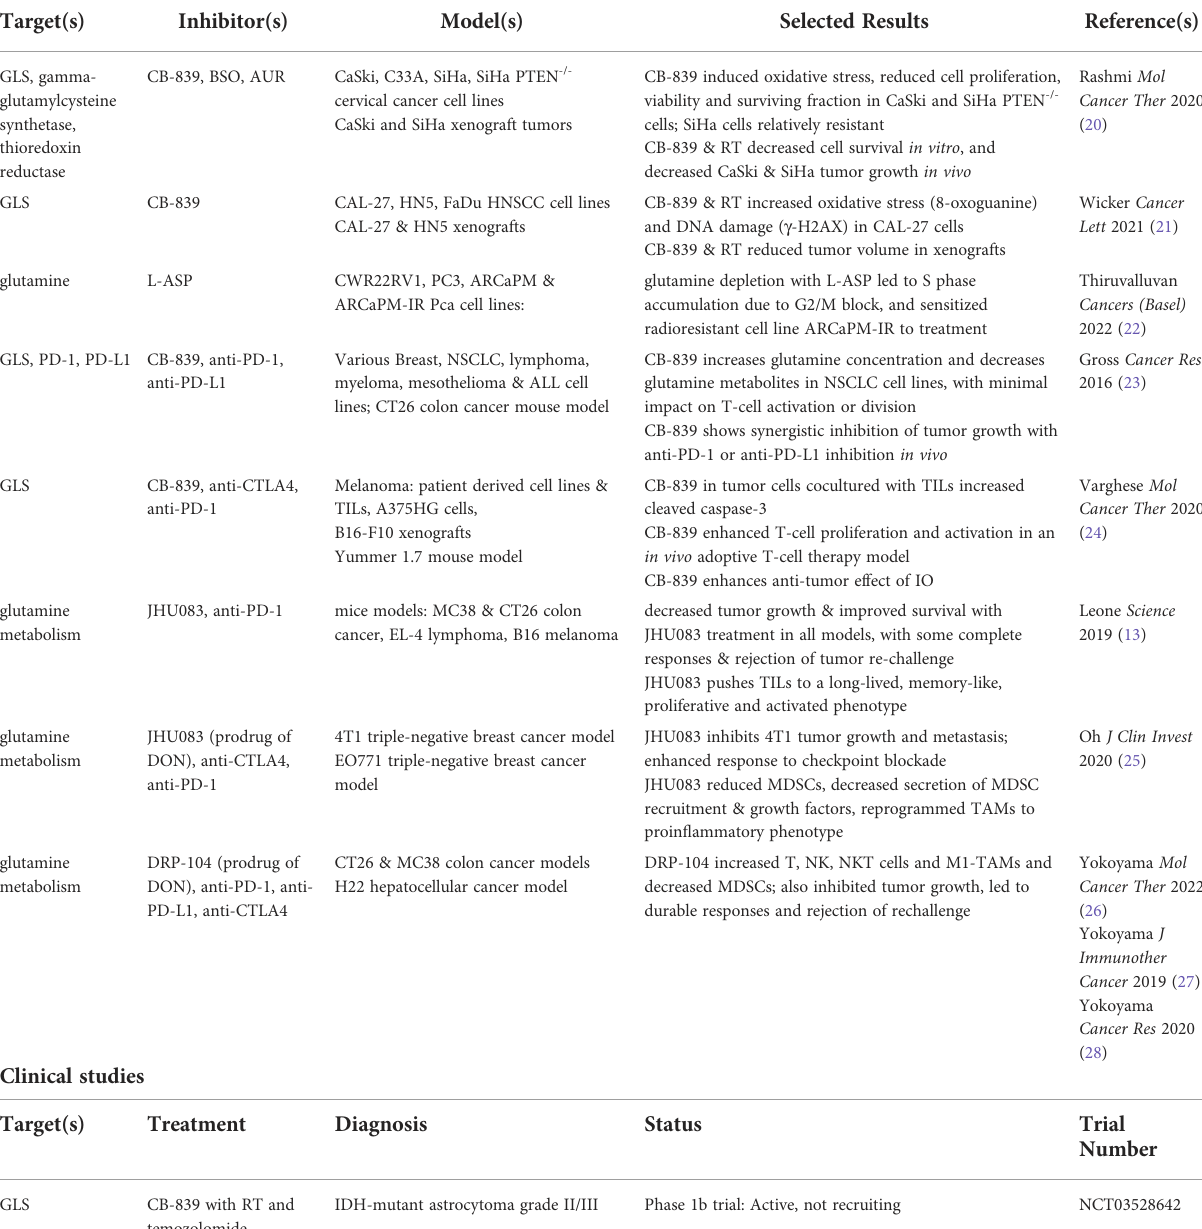
TABLE 1 Selected preclinical studies and clinical trials exploring glutamine metabolism targets for cancer